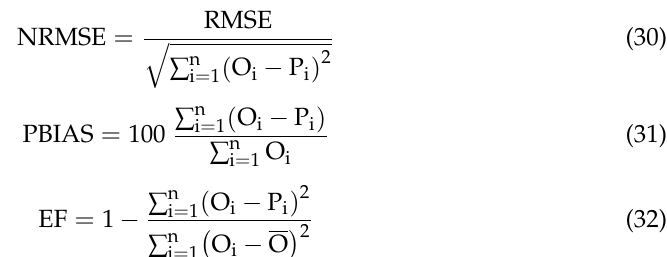
Table 4. Fraction of ground cover f c , crop height (h), fraction of the active ground cover (f c gcover ) and height of the active ground cover (h gcover ) in every plot and all growing seasons. Monferrato (CT) Monferrato (GC) Samora Correia Vineyard Inter-Row Vineyard Inter-Row Vineyard